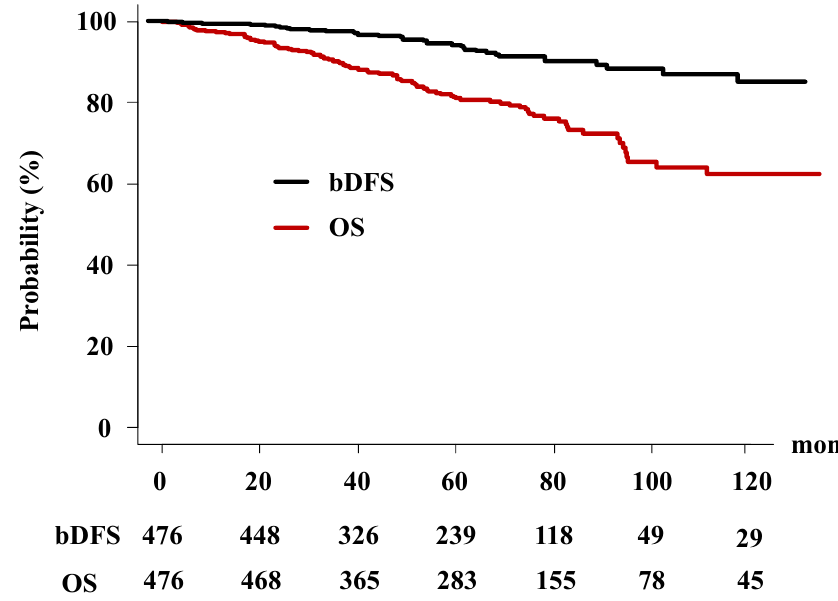
Figure 1. Biochemical disease-free survival (bDFS) and overall survival rate (OS) in patients with clinical localized Gleason 9–10 prostate